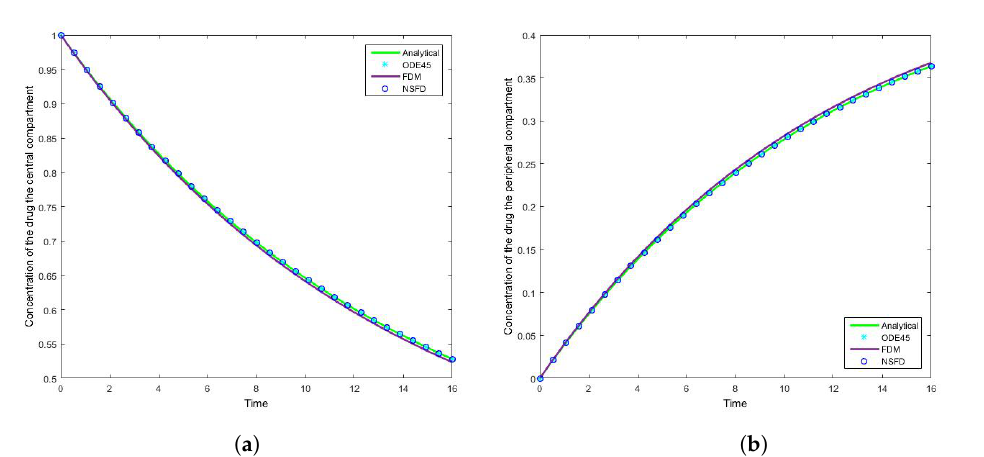
Figure 5. The concentration of the drug for Case 1 where h = 0.53333 in the ( a ) central compartment, and ( b ) peripheral